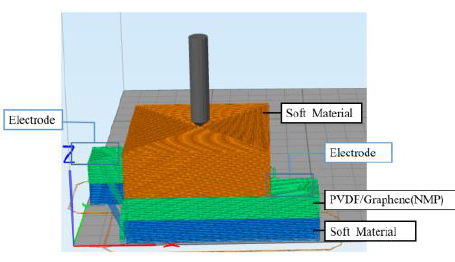
Figure 12. Piezoelectric sensing pad schematic. Table 3. Parameters of piezoelectric sensing